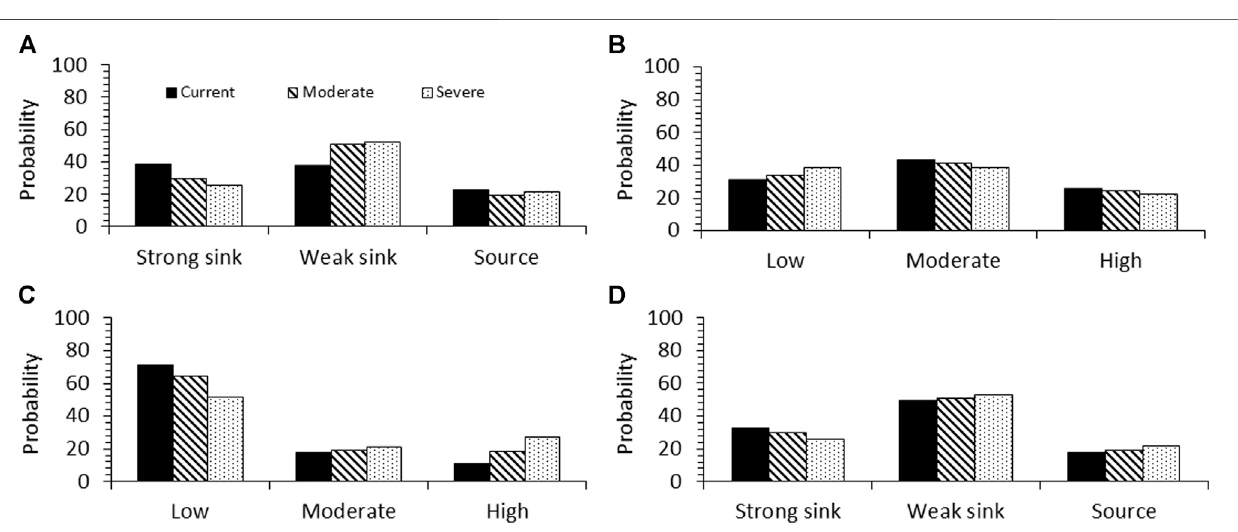
FIGURE 9 | In consideration of current, moderate, and severely warmer scenarios of a landscape containing 43% bogs, 51% fens, and 6% permafrost, probabilitiesof (A) strongsink,weaksink,andsourceofcarbondioxide; (B) low,moderate,andhighmethaneemissions, (C) low,moderate,andhighpeatcombustion, and (D) a strong sink, weak sink, and source of peat